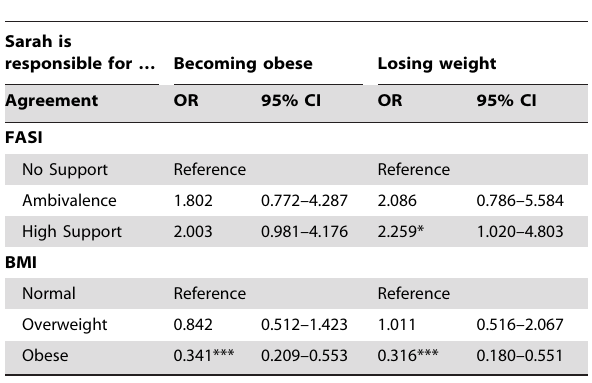
Table 3. Impact of food addiction support and BMI on control based on responses to the vignette.